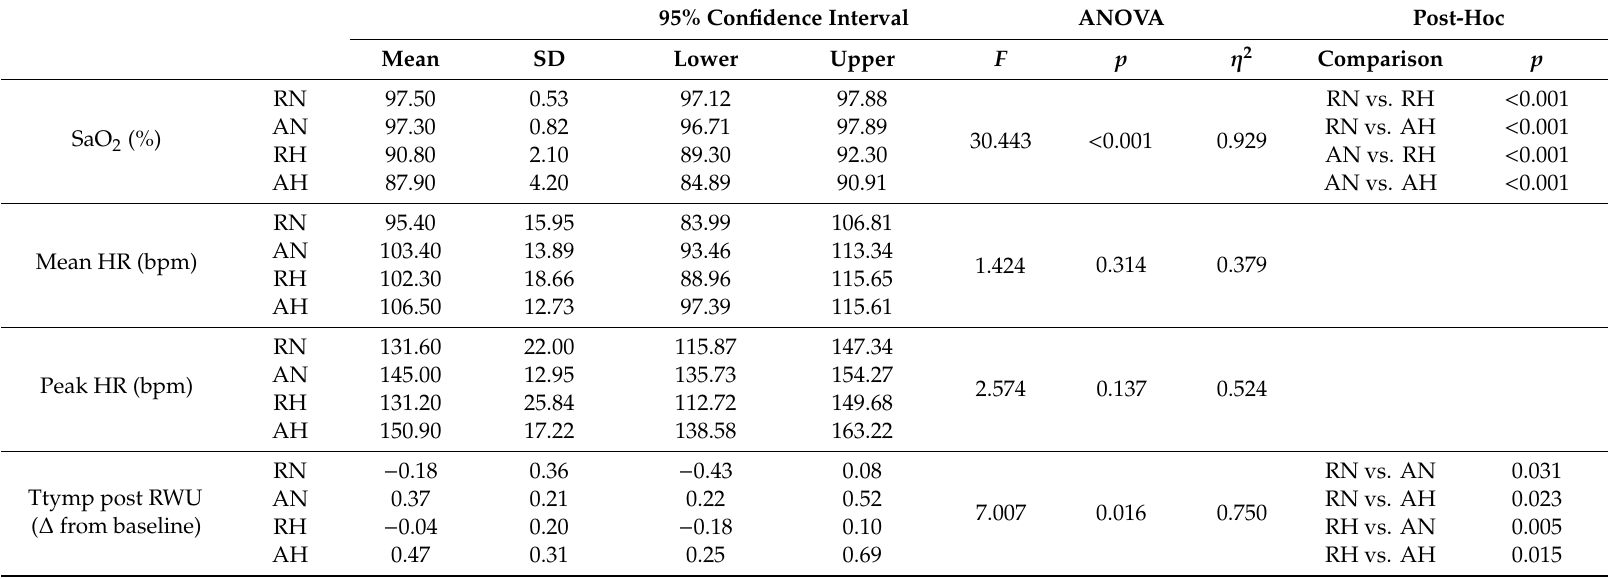
Table 2. Results during the 15 min period after warm up in the four re-warm-up strategies